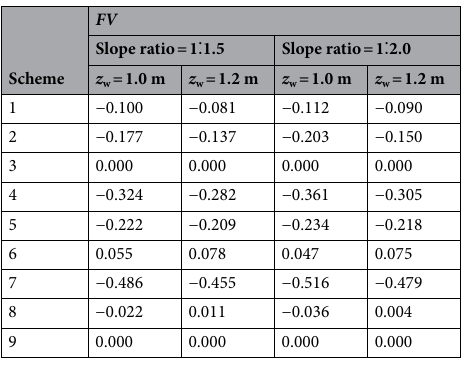
Table 6. Calculation of FV.